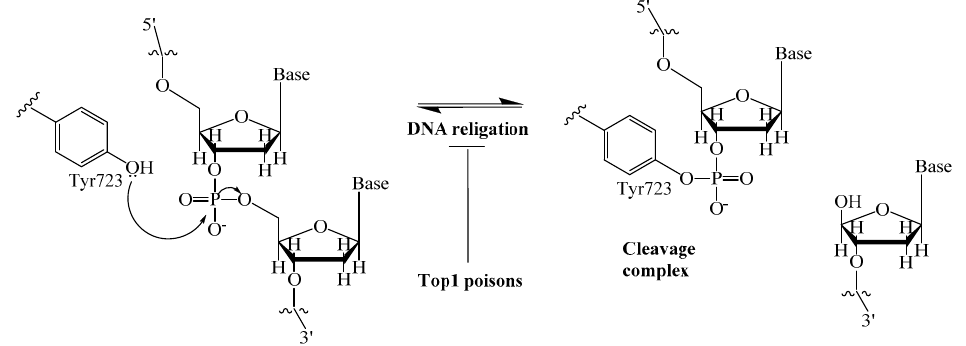
Figure 1. DNA single-strand cleavage by nucleophilic attack of Tyr723 of Top1, and covalent cleavage complex formation.